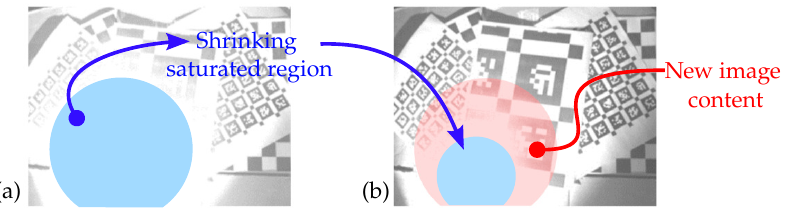
Figure 4. Example of a static scene for which changes in pixel intensity cannot be accurately predicted by g exp . ( a ) Scene with a single large overexposed region. ( b ) The same scene with a smaller overexposed region revealing image content not predicted by g exp